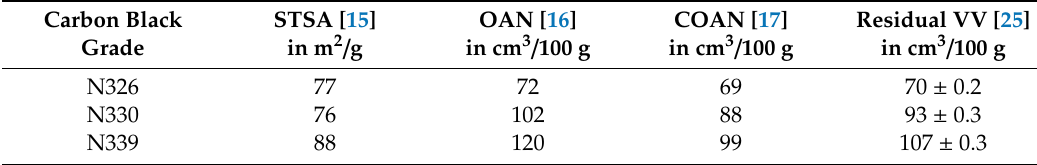
Table 4. Used carbon black types and their analytical